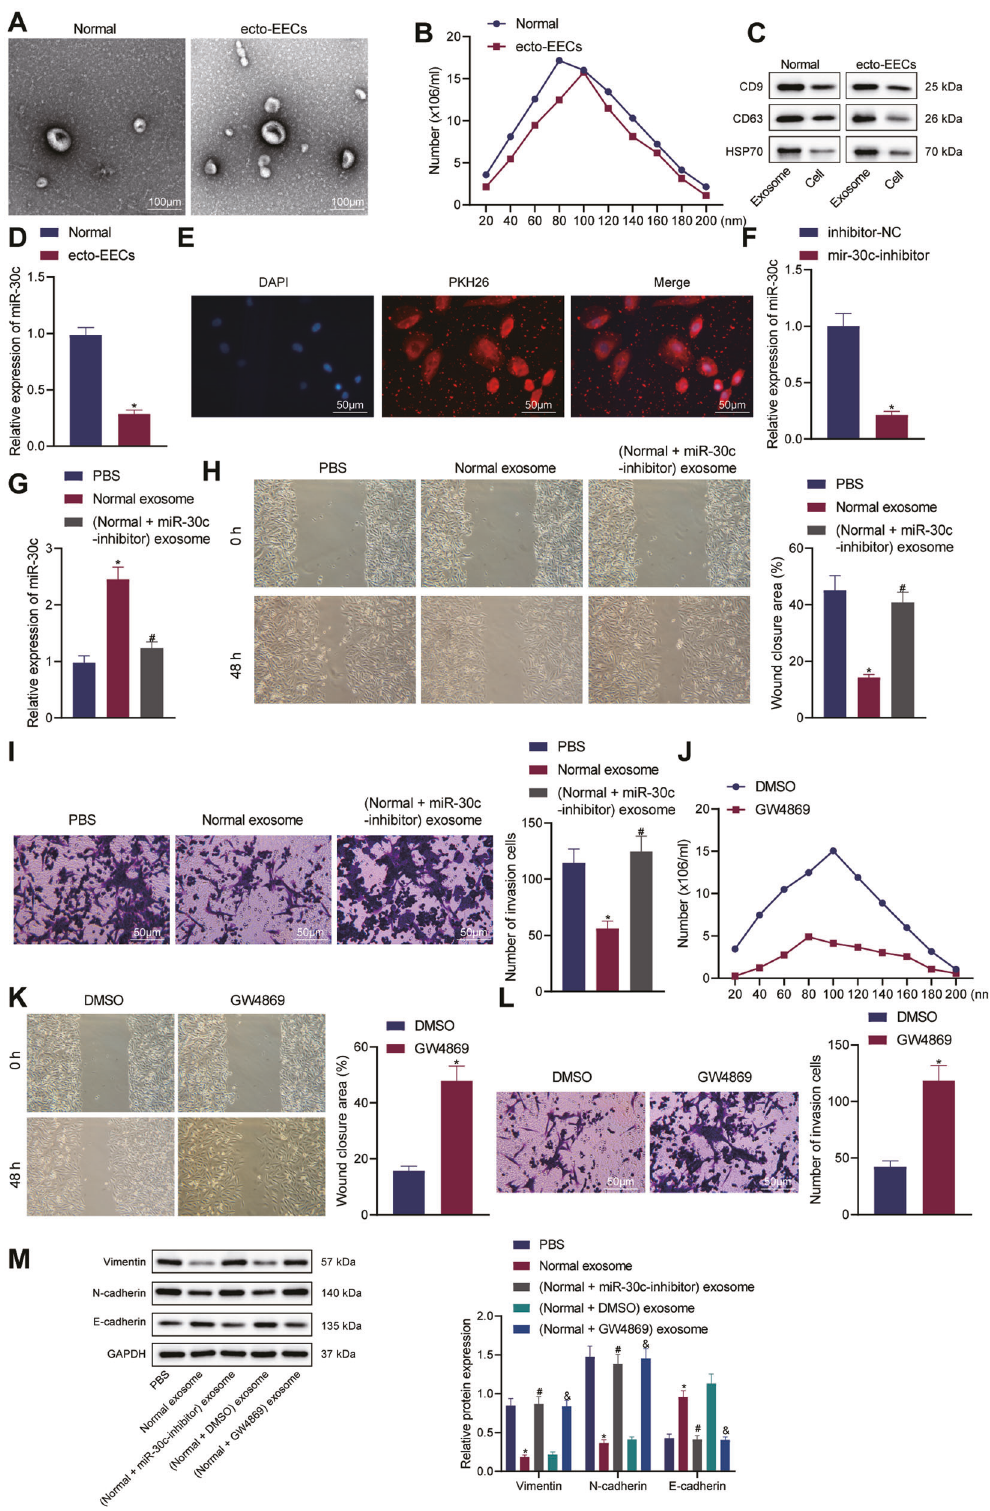
and such effects of EECs-derived exosomes were reversed by either miR-30c knockdown or GW4869 treatment (Fig. 2M). Taken together, our results indicated that exosomes derived from normal EECs suppressed the invasive and migratory potentials of ecto-EECs by delivering